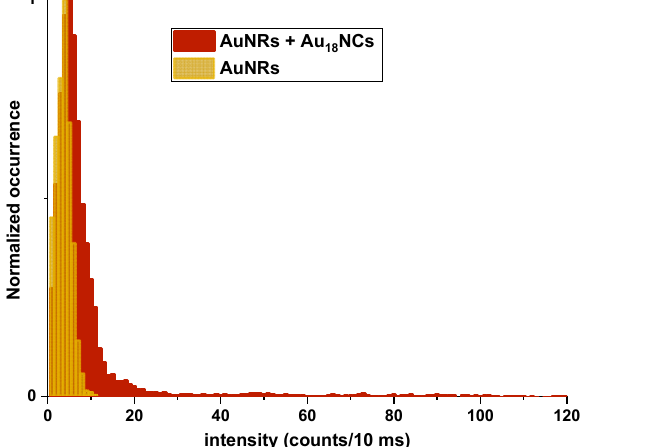
Figure 4. Distribution of number of occurring events of gold nanoclusters TPEL with gold nanorods (red) and gold nanorods itself (yellow).